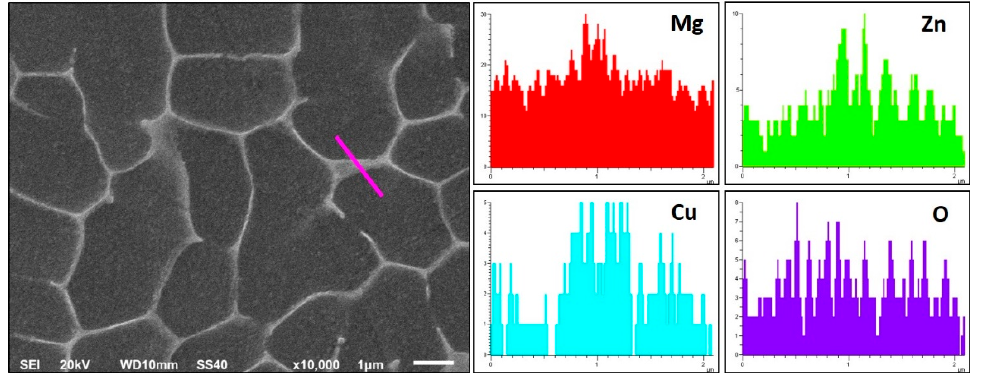
Figure 3. EDS analysis of AA7075 particles along grain boundaries. The image on the left allows for determination of the position where the scan line was performed (pink line). The image on the right shows the elemental profiles from the scan.